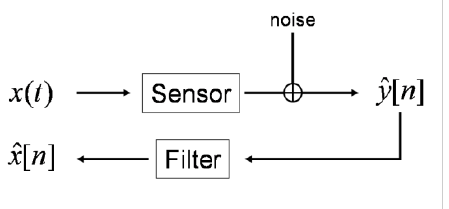
Figure 1. Measurement task of sensor compensation by digital